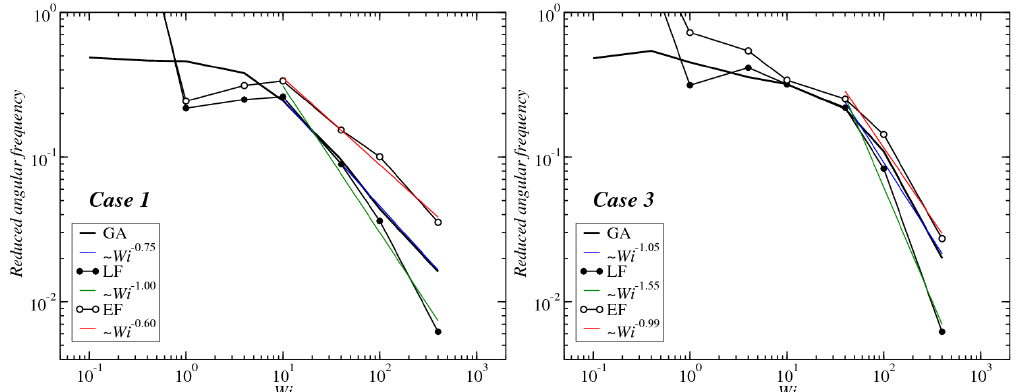
Figure 16. The reduced angular frequencies for Case 1 ( left ) and Case 3 ( right ) evaluated at the LF, the GA and the EF with the longest Eckart time employed, t Eckart = 8000 τ